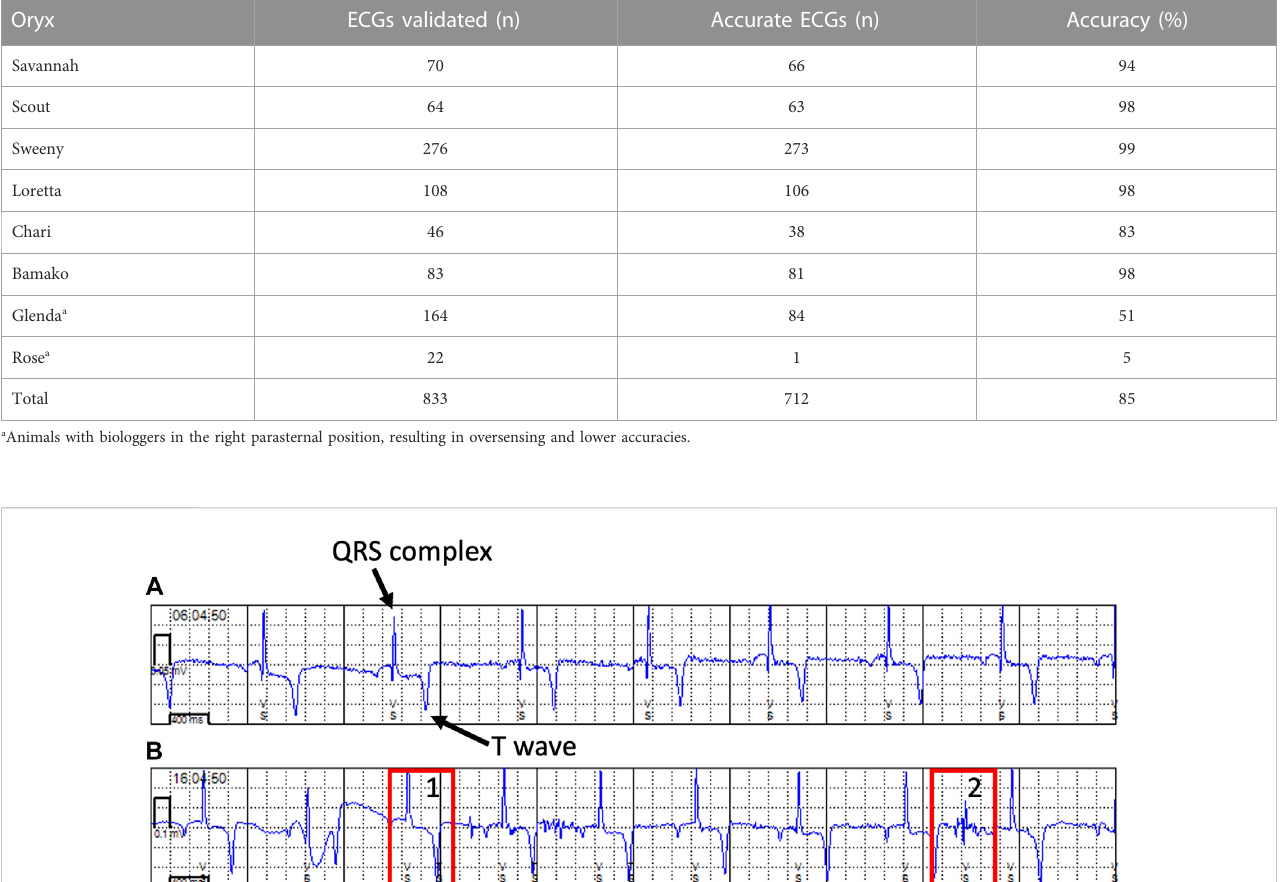
TABLE 2 Accuracy of heart rate averages based on comparison of RR intervals from biologger data with RR intervals calculated from 10-s ECG strips. Oryx ECGs validated (n)